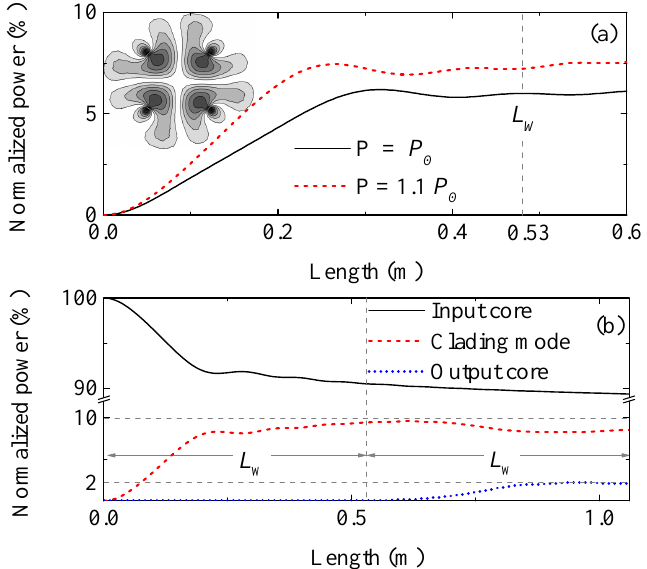
Figure 3. ( a ) Normalized power in the cladding modes for an OLPG with P 0 = 6.47 kW and 1.1 P 0 = 7.14. The inset shows the intensity pattern of the cladding mode. ( b ) Normalized power in the cladding and both core modes for an OLPG with 1.1 P 0 . Notice that the vertical axis is cut to facilitate the analysis of the power transfer. Table 1. ∆ β and P 0 requirement for phase-matching of the chosen cladding mode and their neighbours. Cladding